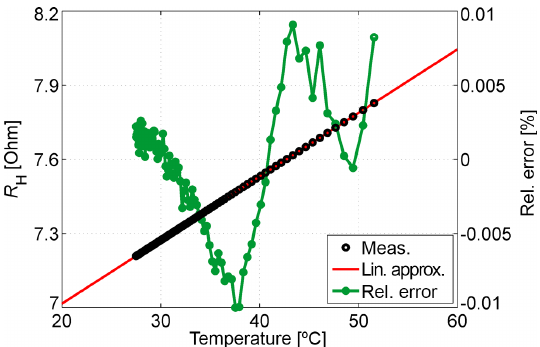
Figure 5. The measured heater resistance R H of the copper lead (black circles) vs. temperature as well as the corresponding linear approximation (red) applied to deduce TCR and R 20 . The green curve depicts the relative error of the linear